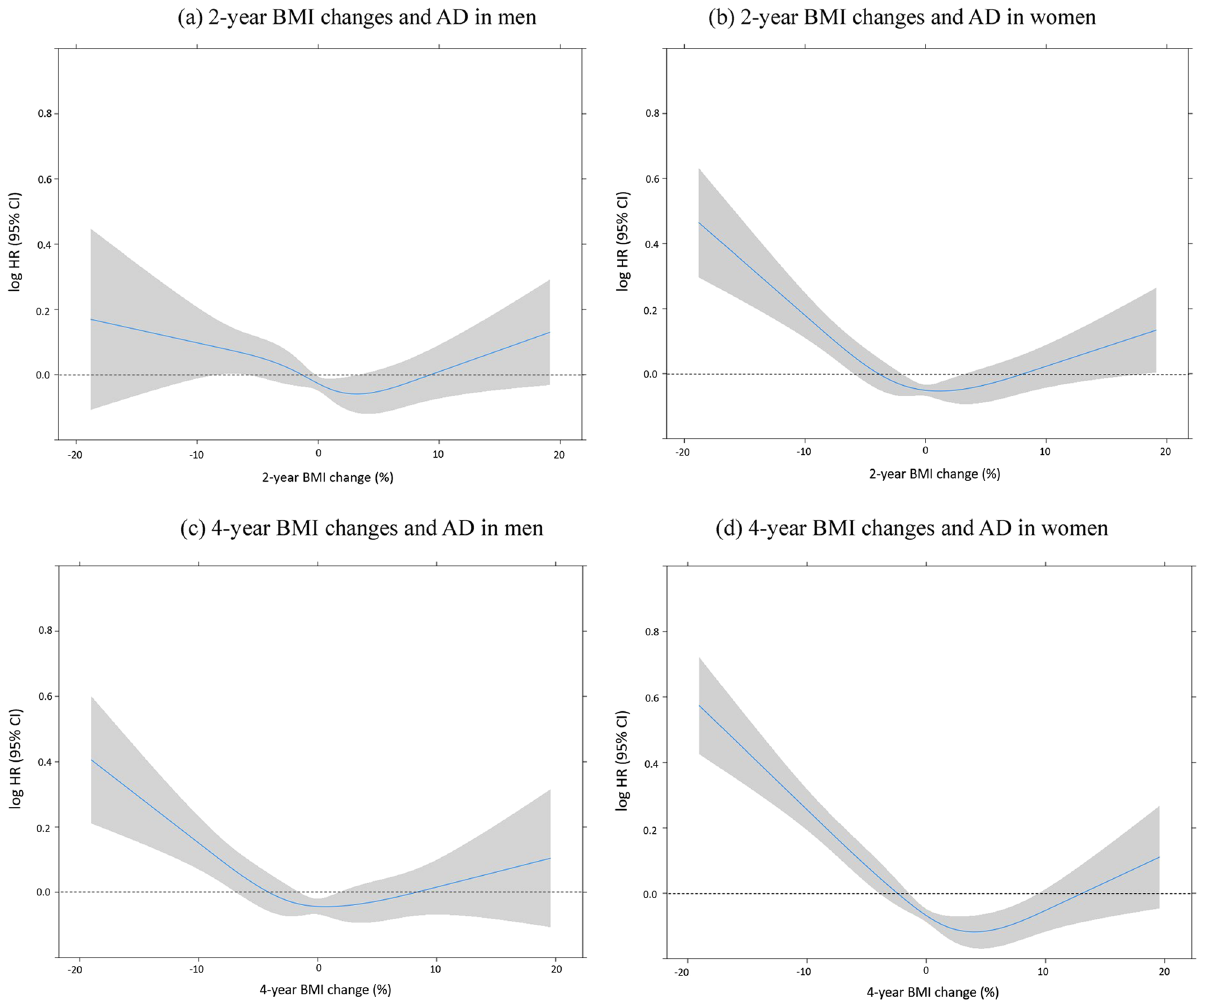
Figure 1. BMI changes and risk of Alzheimer’s